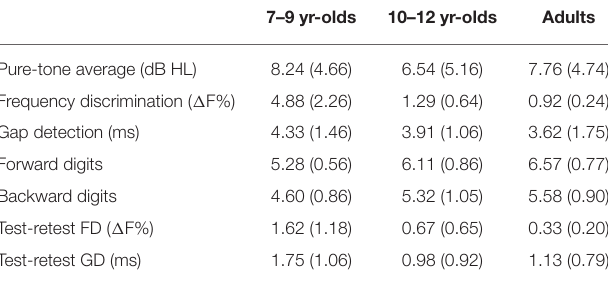
TABLE 2 | Mean and standard deviations in the parenthesis for auditory and working memory